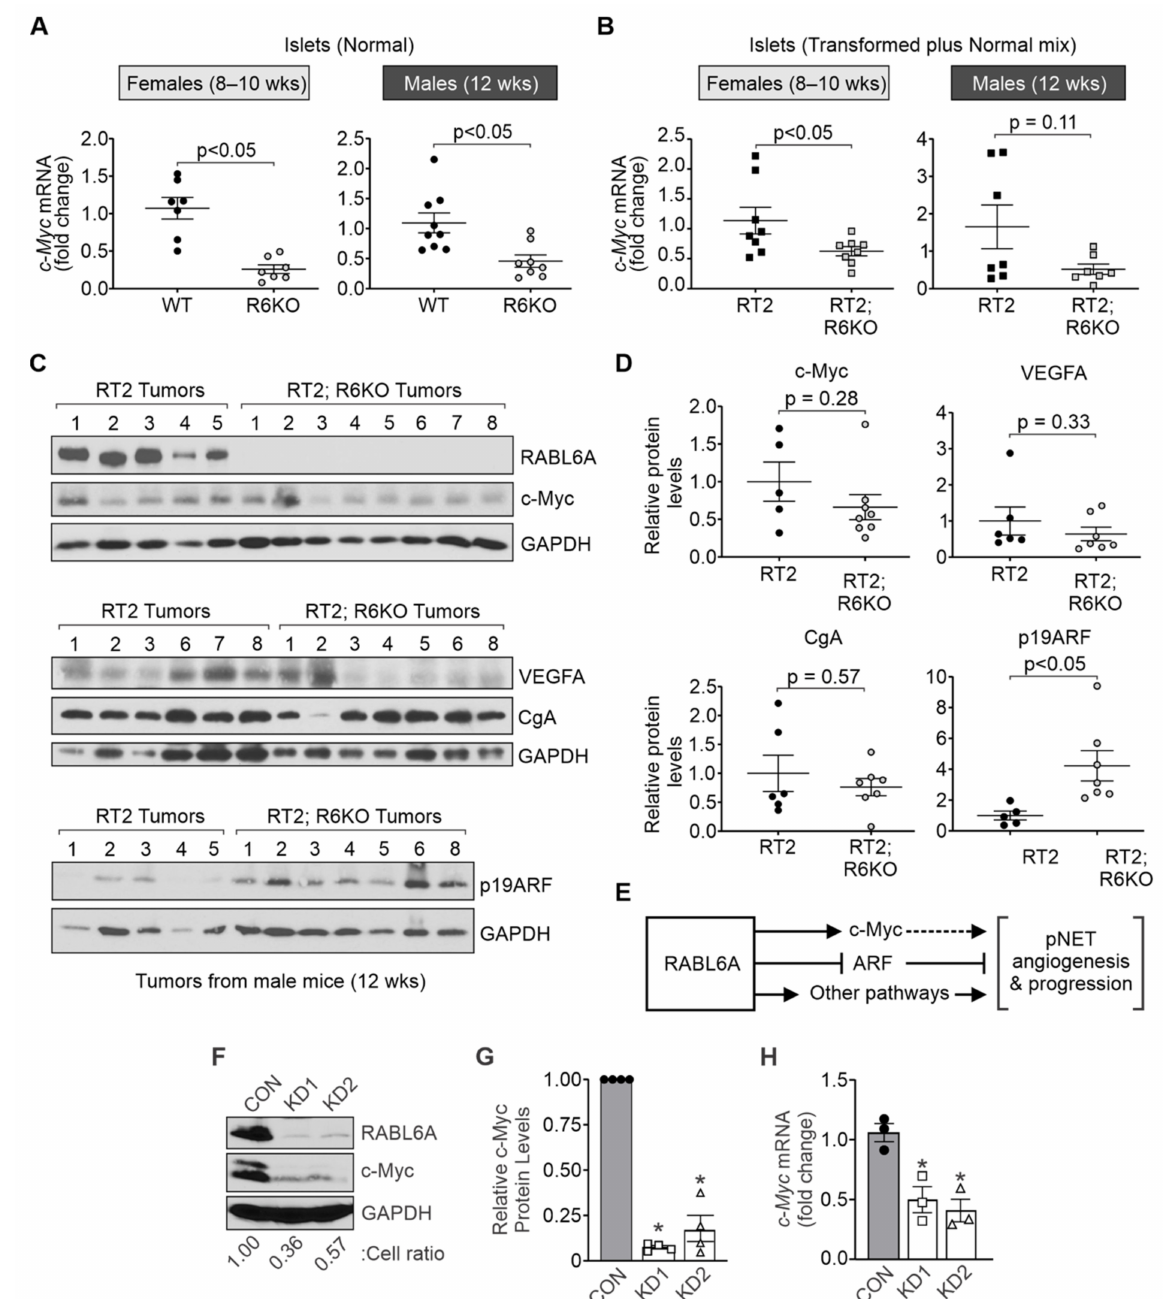
Figure 6. RABL6A promotes c-Myc and limits p19ARF expression in mouse pancreatic islets and tumors. ( A , B ) RNA was isolated from frozen islets (normal or a mixture of transformed plus normal), as indicated, and qRT-PCR was performed to compare the transcript levels of c-Myc between WT and R6KO ( A ) or RT2 and RT2; R6KO ( B ) cohorts. P values are shown. Linear regression was used to evaluate differences in the mRNA levels. Each dot represents an individual animal. N = Females (WT = 7, RT2 = 8, R6KO = 7, RT2; R6KO = 8); Males (WT = 9, RT2 = 7, R6KO = 8, RT2; R6KO = 7). ( C ) Western analysis of the indicated proteins in tumors from 12-week-old male RT2 and RT2; R6KO mice: Top-RABL6A, c-Myc , and GAPDH (loading control); Middle-VEGFA, Chromogranin A (CgA), and GAPDH (minus #4 and 5 of RT2 tumors and #7 of RT2; R6KO tumors; plus new #6, 7, and 8 of RT2 tumors); Bottom-p19ARF and GAPDH (minus #7 since it was used up). The different sets of blots represent separate experiments using many of the same lysates. GAPDH signals appear slightly different due to different gels and ECL exposure times. ( D ) ImageJ densitometric analysis of western data (from C) for relative levels of c-Myc , VEGFA, CgA and p19ARF in RT2; R6KO tumors relative to RT2 controls. Each dot represents an individual animal. N = c-Myc (RT2 = 5, RT2; R6KO = 8); VEGFA and CgA (RT2 = 6, RT2; R6KO = 7); p19ARF (RT2 = 5,